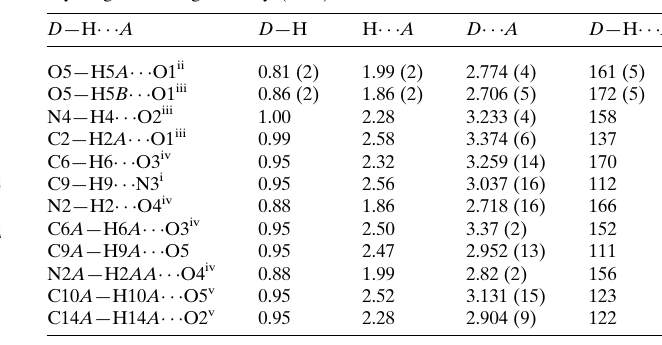
Table 1 Hydrogen-bond geometry (A˚ , (cid:5) ).